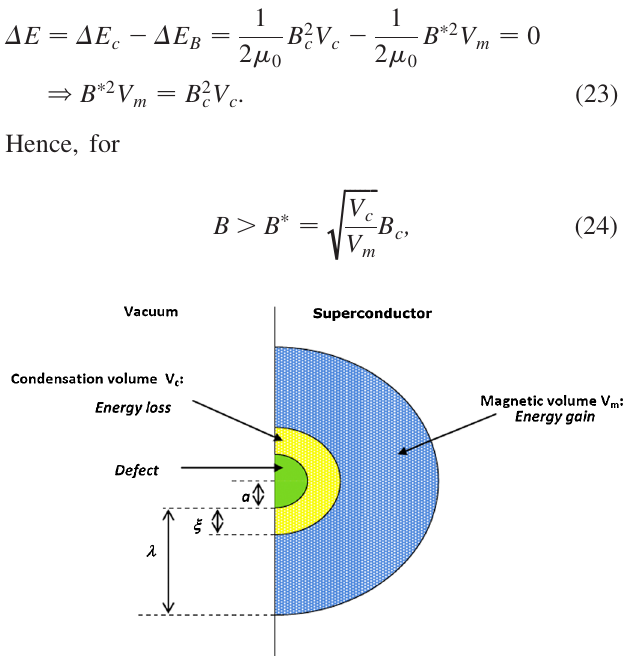
FIG. 1. The superconductor loses energy inside the condensa- tion volume V c and gains energy inside the magnetic volume V m